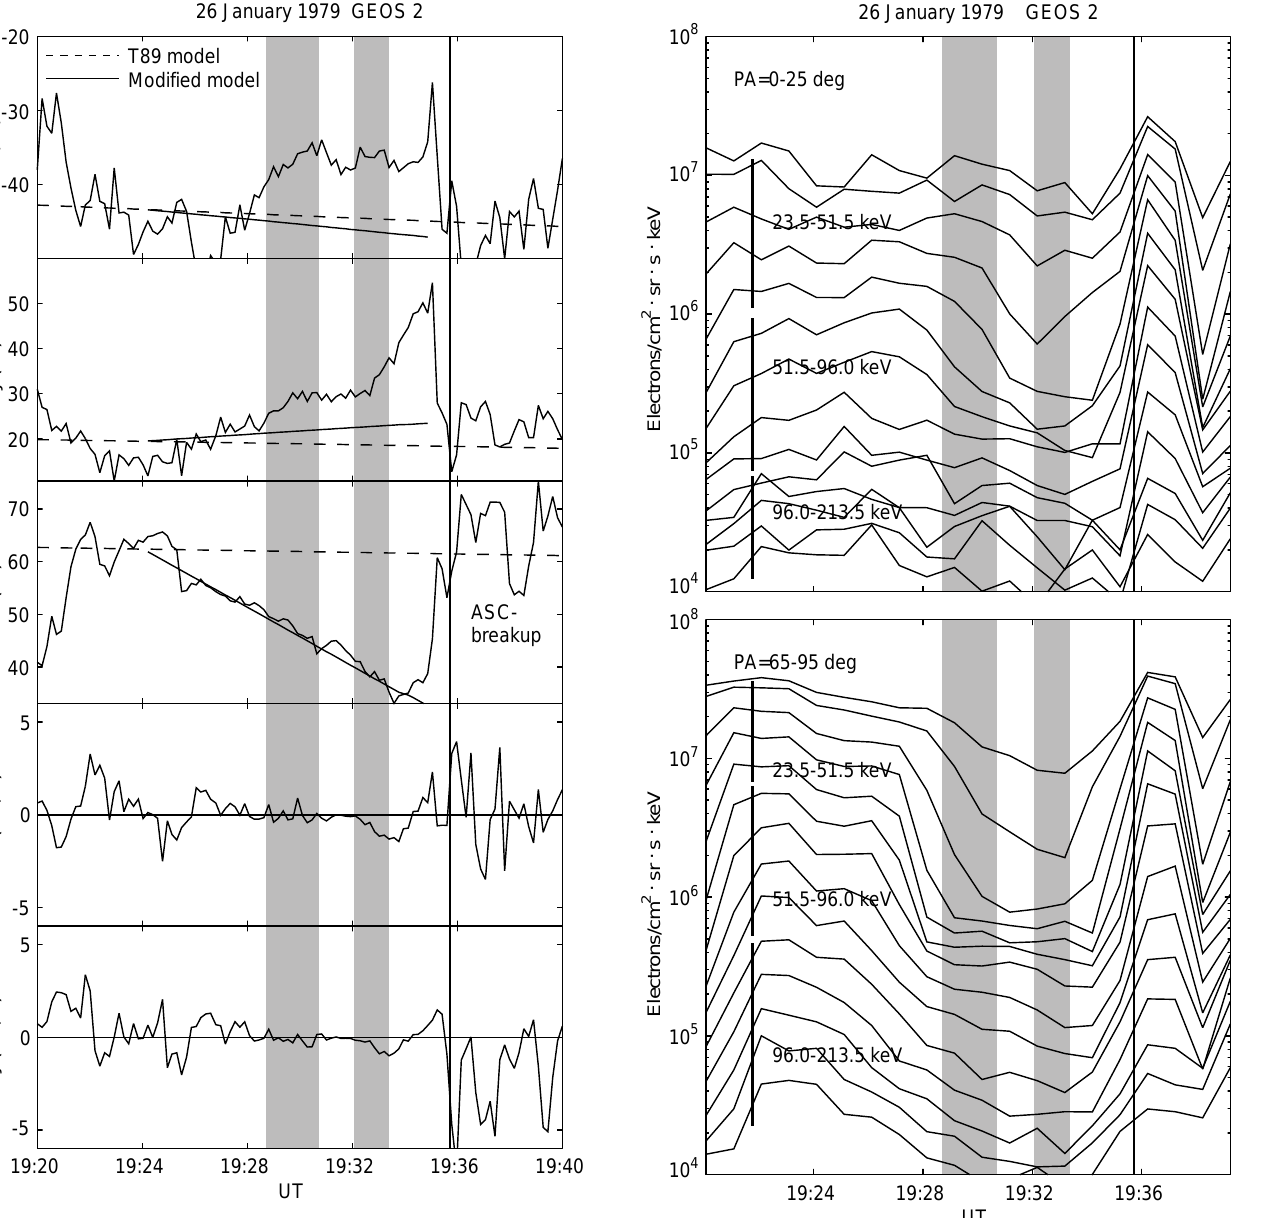
Fig. 4. Field recordins (in GSM coordinates) by GEOS 2 (satellite location: X GSM from (cid:255) 5 : 0 to (cid:255) 5 : 4 R E , Y GSM from 4.1 to 3 : 6 R E , and Z GSM from (cid:255) 1 : 2 to (cid:255) 1 : 4 R E ) around the auroral fadings on 26 January 1979: ( from top to bottom ) B x ; B y ; B z ; E x , and E y . The gray shadings show the fading times and the vertical solid line marks the time of the auroral breakup. In the three first panels the time trends marked with the dashed and solid lines are the field values according to T89 and the modified magnetic field model, respectively.